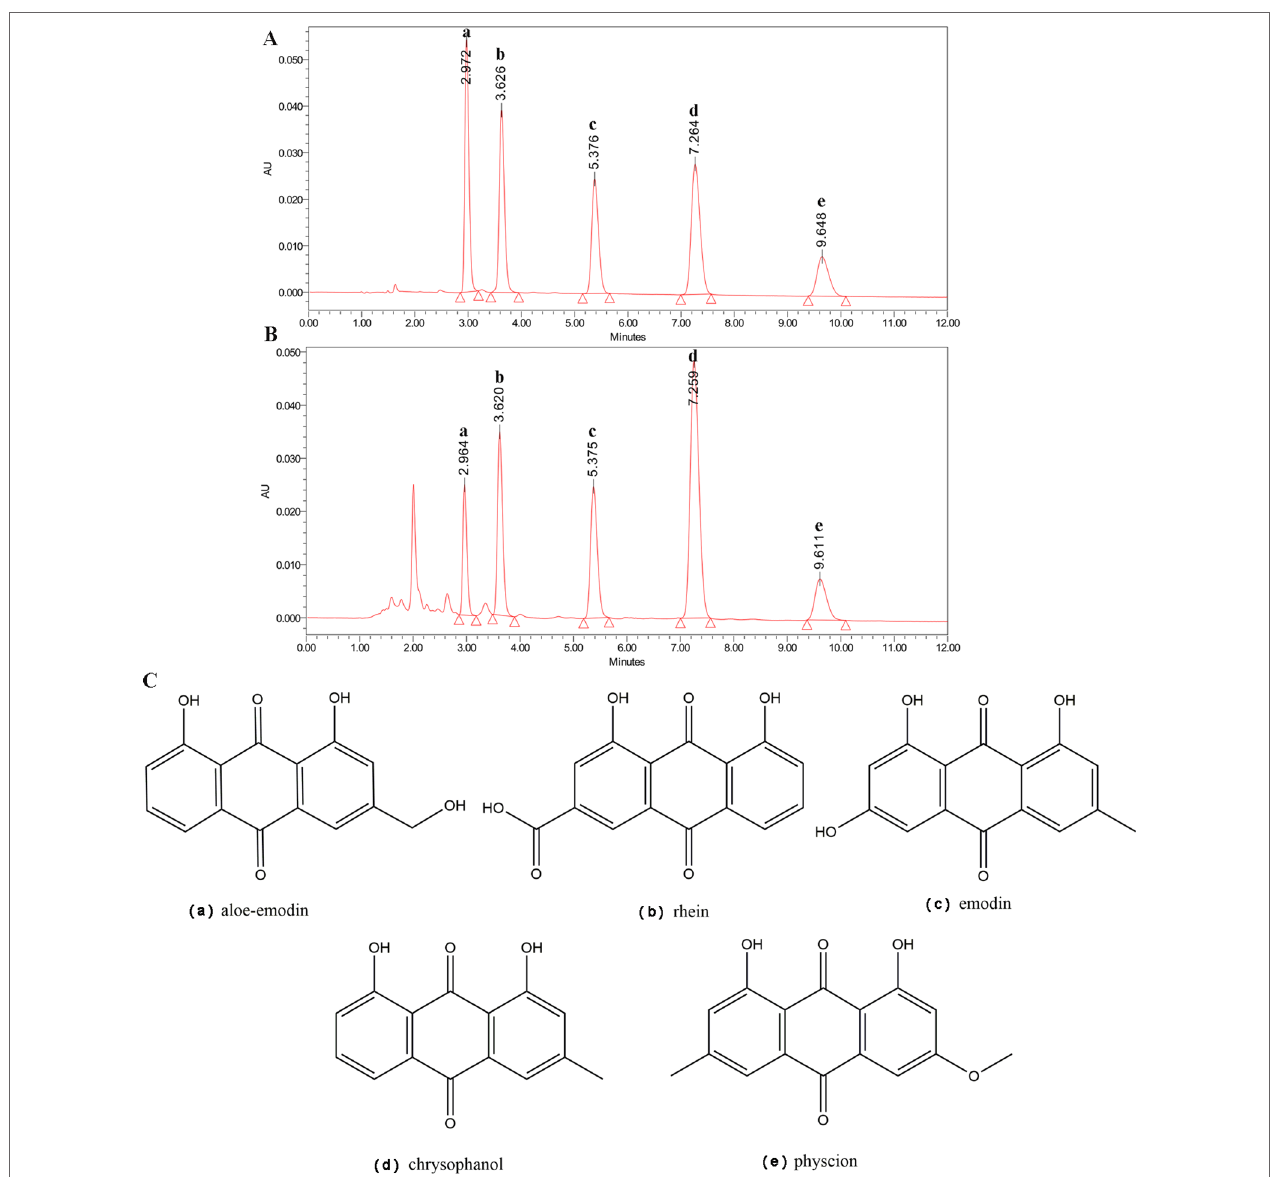
FIGURE 1 | HPLC analysis of R. tanguticum nanoparticles. (A) HPLC of the standard reference compounds. (B) The chemical contents of R. tanguticum nanoparticles, peak a for aloe–emodin, peak b for rhein, peak c for emodin, peak d for chrysophanol, and peak e for physcion, respectively. (C) Structure of identified components of R. tanguticum